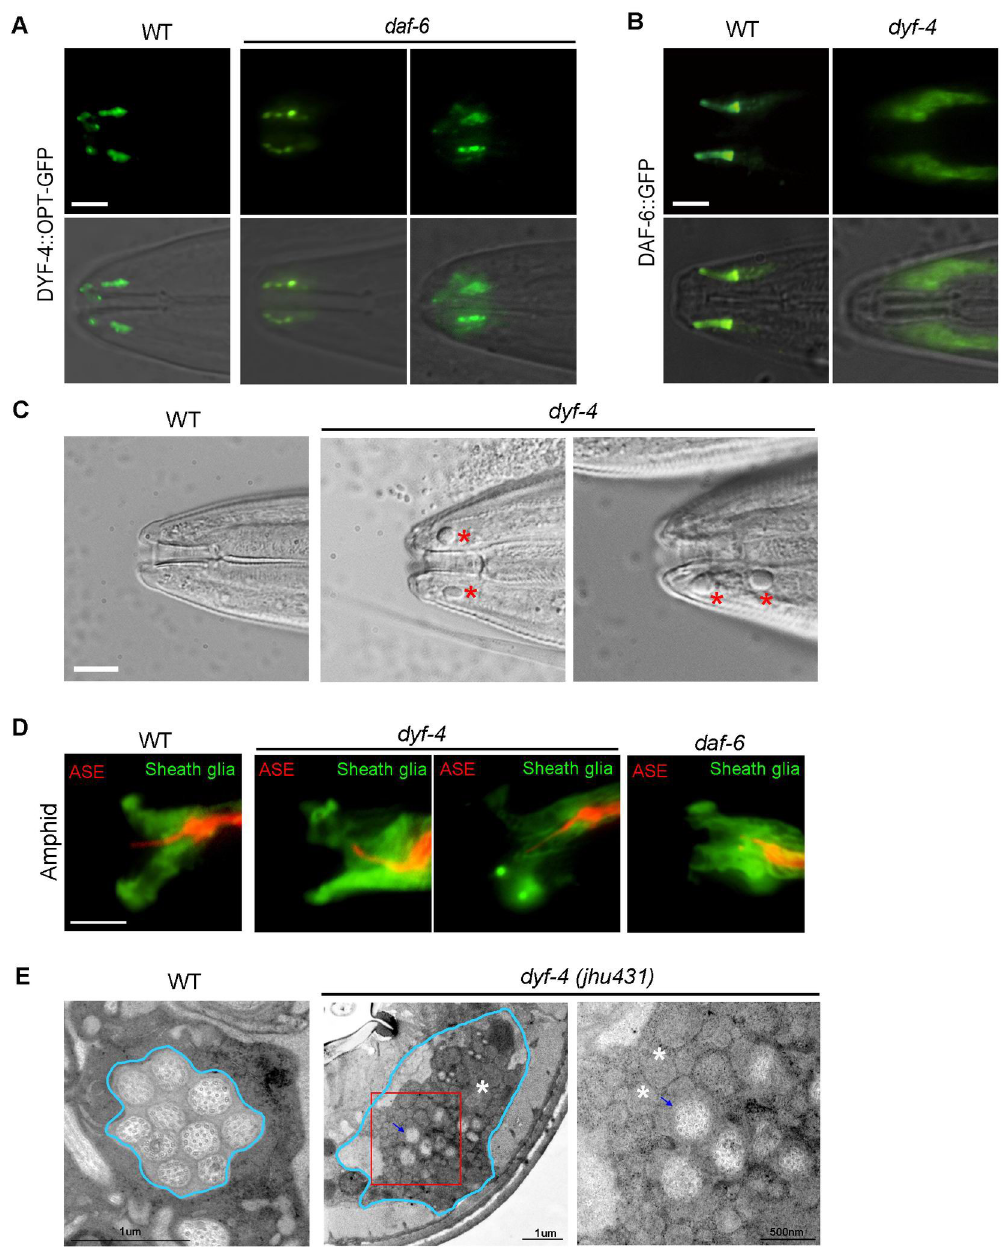
Fig 4. DYF-4 is required for DAF-6 localization and glia channel formation. (A) Subcellular localization of DYF-4:: OPT-GFP in young adults of WT and daf-6 worms. The localization of DYF-4 was basically normal in daf-6 mutants. n > 100 worms. (B) Subcellular localization of DAF-6::GFP in young adults of WT and dyf-4 worms. DYF-4 is required for the glial channel localization of DAF-6. n > 100 worms. Scale bars: 5 μ m. (C) DIC images of heads of WT and dyf-4 mutants. Vacuolar structures were observed in dyf-4 mutants. Scale bars: 5 μ m. (D) The amphid channel expressing T02B11 . 3pro ::GFP (Green, sheath glia) and gcy-5pro ::mCherry (Red, ASE neuron) in indicated genetic background. The ASE cilium extended through sheath cell lumen in WT, while it often bended and failed to extend through sheath cell lumen in both dyf-4 and daf-6 mutants. (E) TEM images of cross-sections of amphid channel in WT and dyf-4 mutants. Blue arrow: cilia; White asterisk: vesicular accumulations. Magnified red square region in dyf-4 mutants is shown on the right.